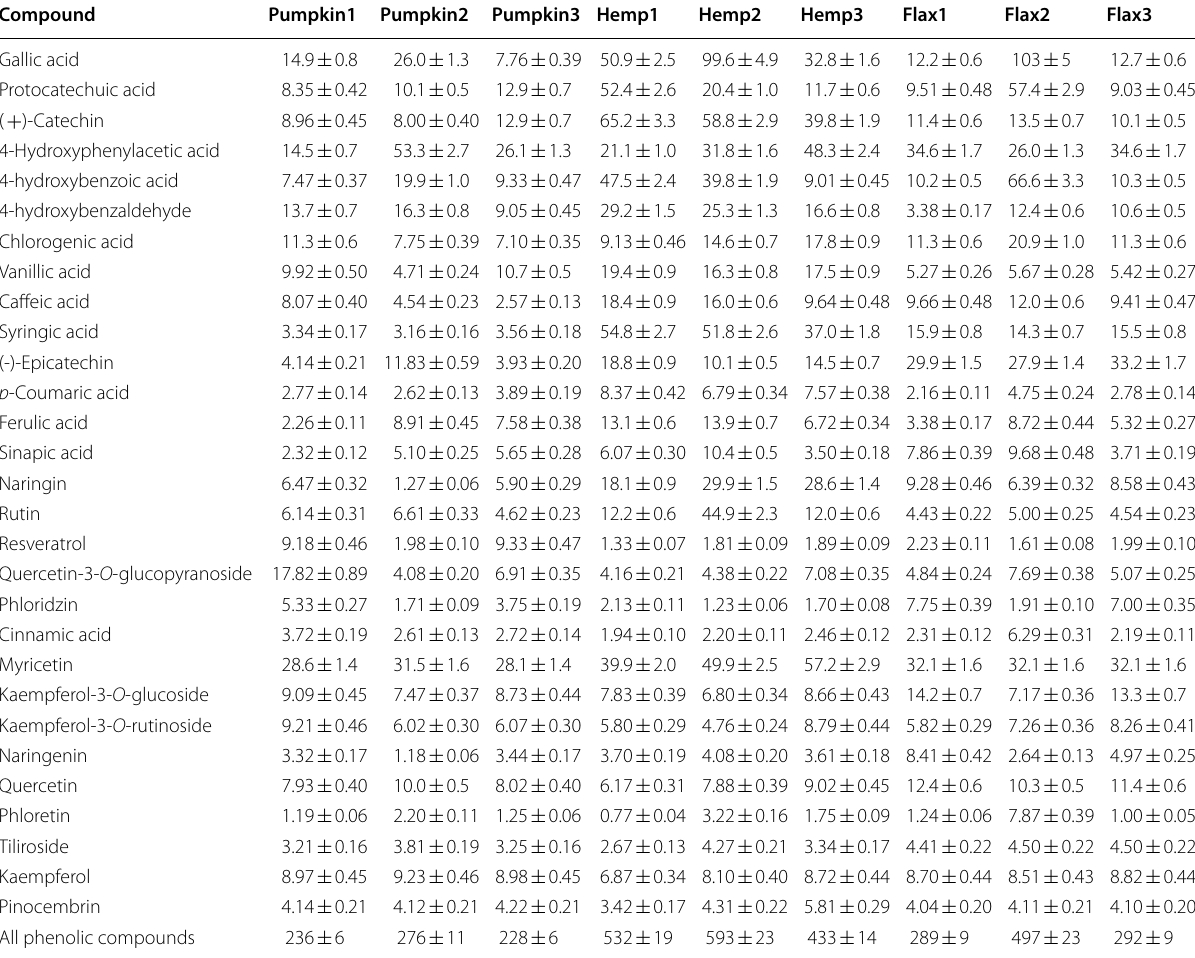
Results are expressed as mean SD (mg of compound per 100 g dw, n 3) ± = Subcritical water extraction carried out with a solid to solvent ratio of 1:30 (w/v), 1 h at 160 °C with (1) 20 bar N 2 , (2) 20 bar N 2 with 0.05 M HCl, (3) 20 bar CO